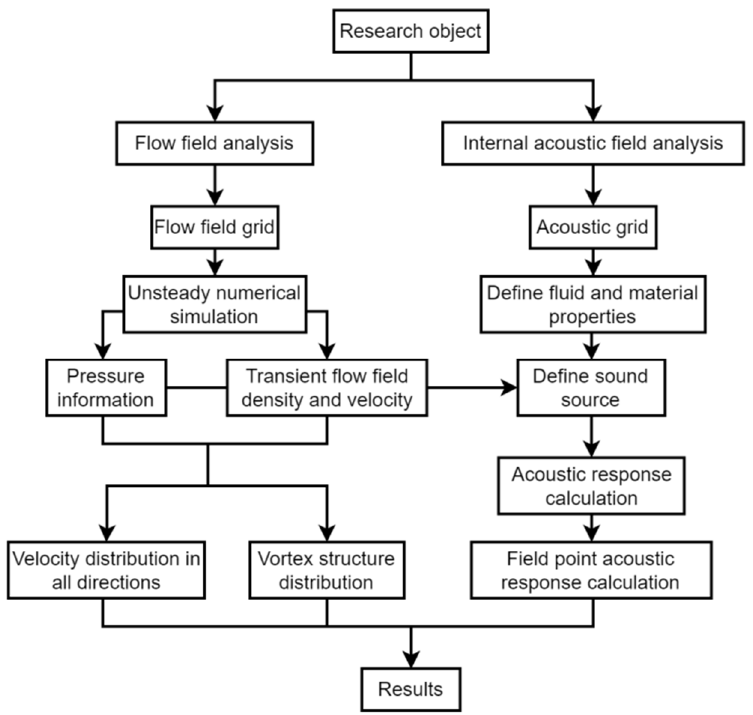
Figure 1. Analysis flow